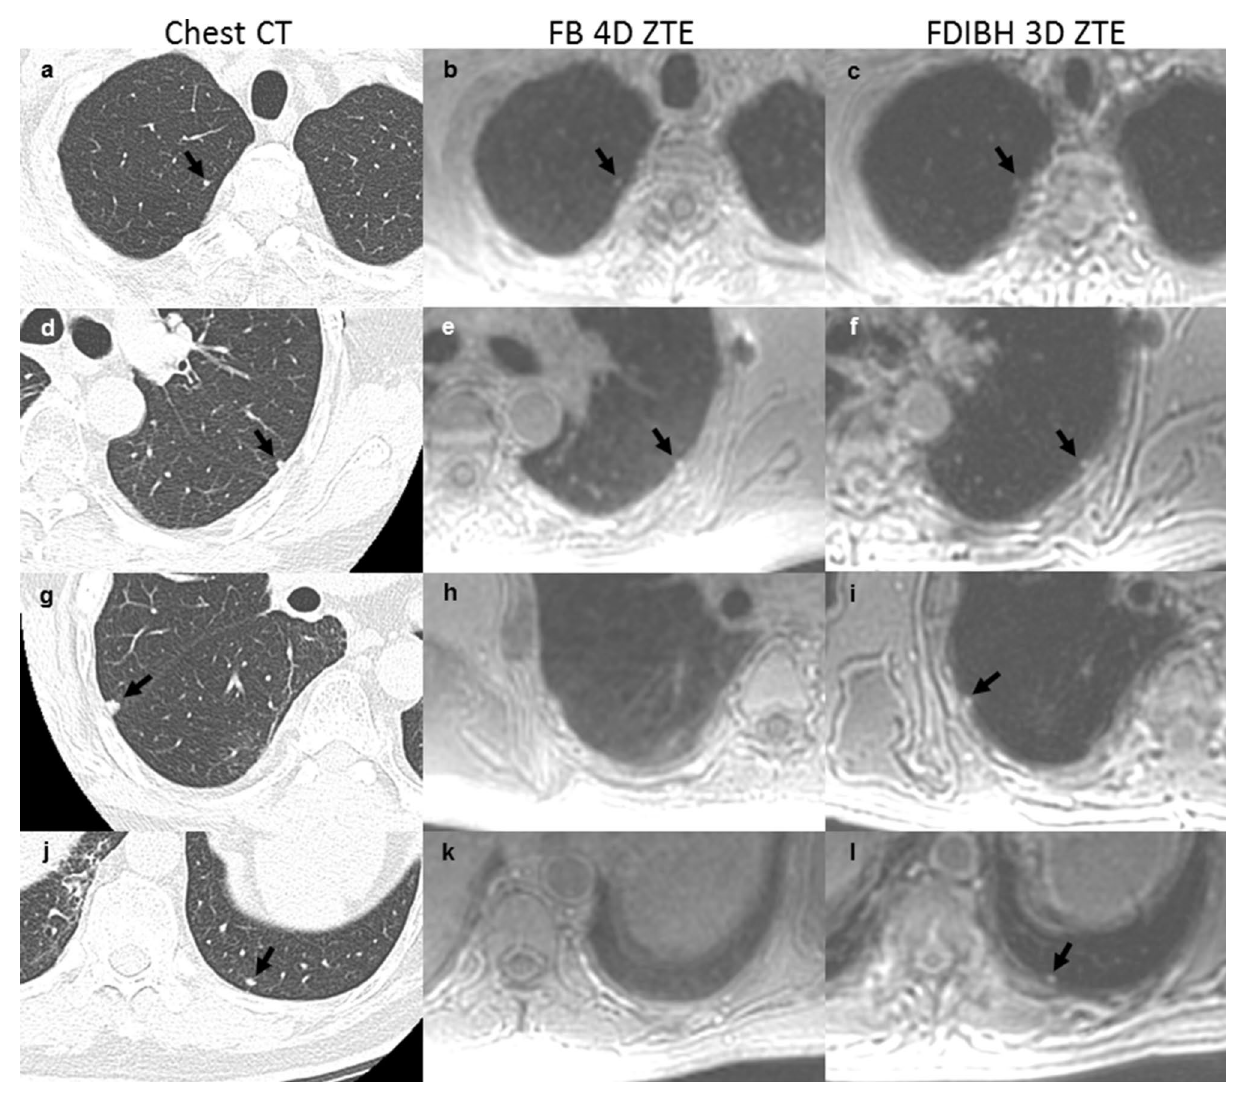
Figure 2. The traditional dual-echo gradient T1-weighted images and the FDG images failed to detected lung metastases in a 63-year-old male thyroid cancer patient. The FB 4D ZTE ( b , e ) and the FDIBH 3D ZTE ( c , f ) detected a 2.9 mm right upper lobe nodule and a 3 mm left upper lobe nodule. The FDIBH 3D ZTE additionally detected a 5 mm right upper lobe nodule ( i ) and another 4 mm left lower lobe nodule ( l ). All the detected nodules were identified by arrows. The lung volume of the FDIBH 3D ZTE was more similar to that of the full expansion chest CT than that of the FB 4D